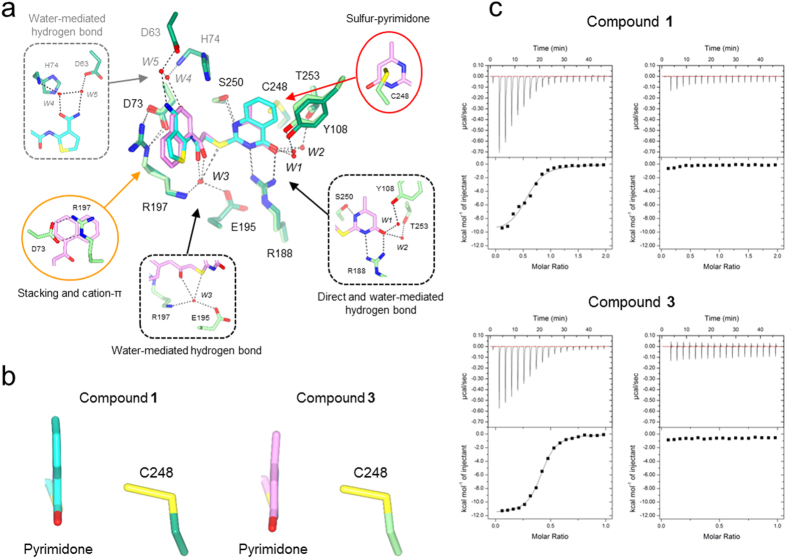
Crystal structure of 3MST-inhibitor complex and ITC analysis.(a) Detailed view of the active site of the two protein-inhibitor complexes. Residues of 3MST-compound 1 complex (emerald green), residues of 3MST-compound 3 complex (light green), compound 1 (cyan), compound 3 (pink), oxygen atoms of residues and compounds (red), nitrogen atoms (blue), sulfur atoms (yellow), hydrogen bonding (black dotted lines), waters of 3MST-compound 1 complex (red spheres) and waters of 3MST-compound 3 complex (red spheres) are shown. (b) Detailed view of the 4-pyrimidone-like aromatic ring and the side chain of persulfurated C248. The side chain of 3MST-compound 1 complex (emerald green), the side chain of 3MST-compound 3 complex (light green), compound 1 (cyan), compound 3 (pink), oxygen atoms (red), nitrogen atoms (blue) and sulfur atoms (yellow) are shown. (c) ITC analysis of 3MST injected with compound 1 (upper) and compound 3 (bottom). The titration plots (top graph) and fitting curves (bottom graph) of persulfurated 3MST (left) and the non-persulfurated 3MST (right) are shown.